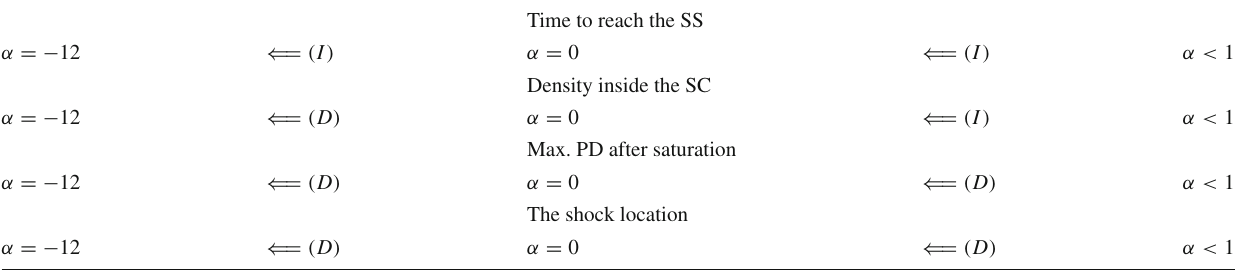
Fig. 10 The maximum value of the m = 1 power mode ( A ( max )) versus mod Gauss–Bonnet coupling constant α . Each value of power mode is extracted from the data after growth rate reaches to the saturation point. The star symbol represents the maximum power mode for the Schwarzschild black hole